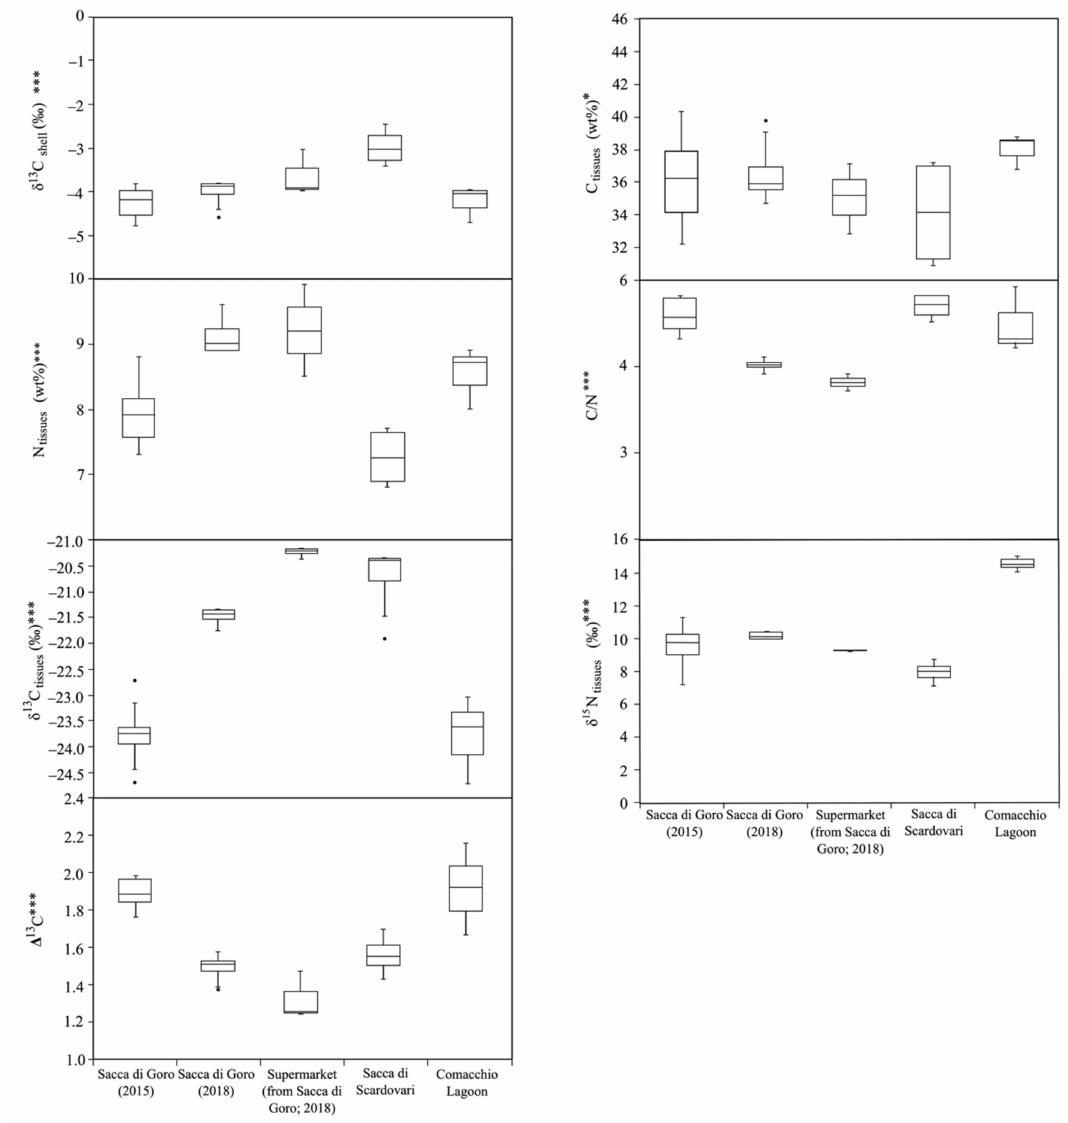
Figure 3. Box plot of elemental and isotopic compositions of carbon (C) and nitrogen (N) in the shells and tissues of manila clam samples collected onsite from north-western Adriatic lagoons and bought at the local supermarket. One-way ANOVA is also reported (* p < 1; *** p <